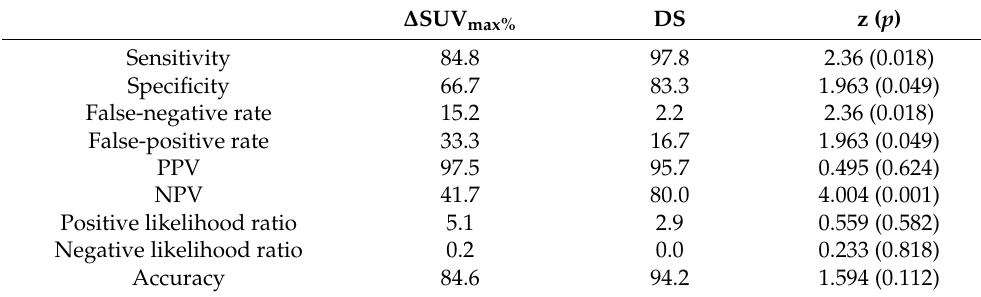
Table 5. Comparison of ∆ SUV max% and DS performance levels at post-therapy PET-CT in predicting a therapy response at 24 months. Values are expressed as